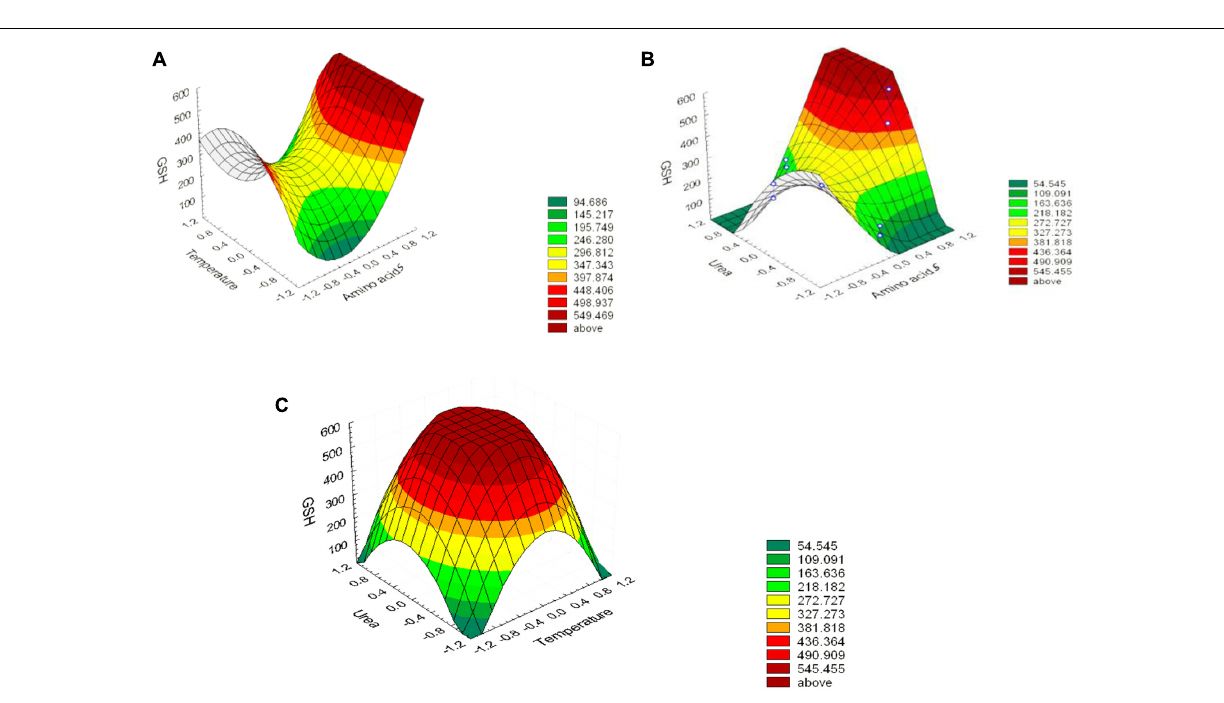
FIGURE 5 | Three-dimensional response surfaces representing the effect of the three significant parameters on the GSH production by L. plantarum L 7 isolate. When the effect of two parameters was plotted, the remaining one was set at central level. (A) urea and precursor amino acids, (B) temperatures and precursor amino acids, (C) temperatures and urea. Outside (–1, 1) is a result of extrapolation of the